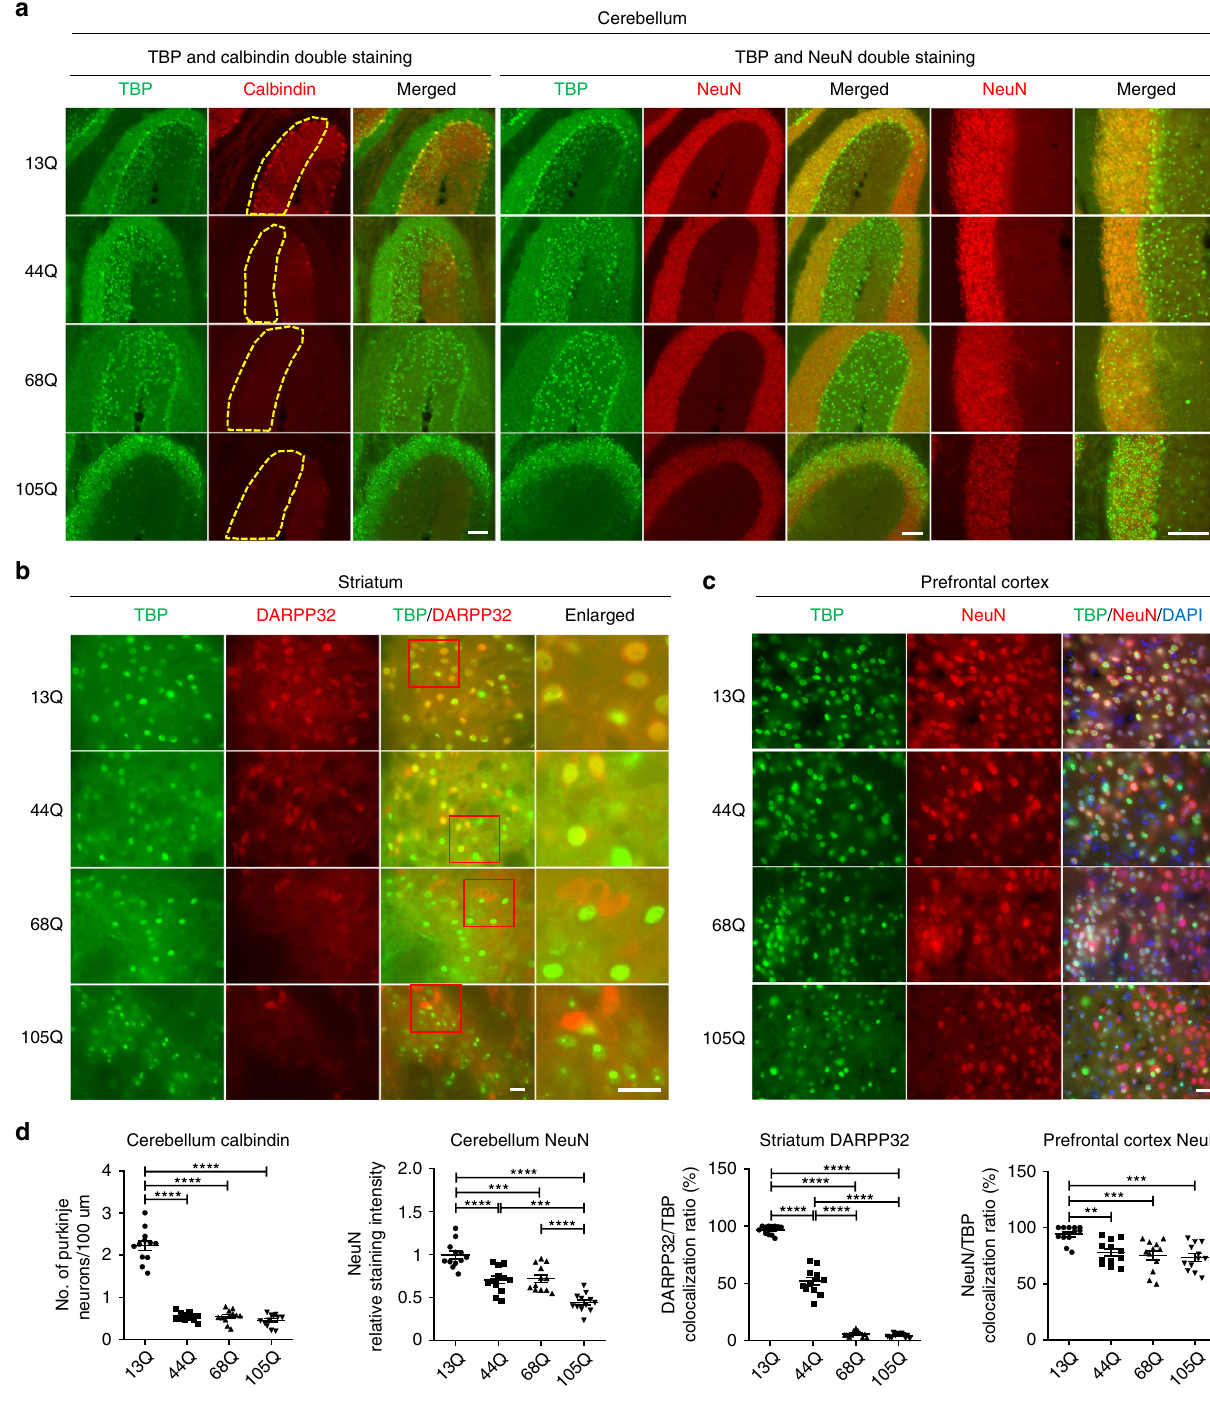
Fig. 2 Differential effects of mutant TBP in different brain regions. a Immuno fl uorescent staining of the cerebellum from AAV- TBP -injected wild-type mouse brains. Antibodies to TBP, NeuN, and calbindin were used. Scale bar = 100 μ m. b Immuno fl uorescent staining of the striatum from AAV- TBP - injected wild-type mouse brain. Staining with antibodies to TBP and DARPP32, a marker for medium spiny neurons, showed a reduced expression of DARPP32 in a polyQ length-dependent manner. Scale bar = 20 μ m. c Immuno fl uorescent staining of the prefrontal cortex from AAV- TBP -injected wild- type mouse brain with anti-TBP and anti-NeuN antibodies. Scale bar = 20 μ m. d Quanti fi cation of neuronal loss in the cerebellum, striatum, and prefrontal cortex from AAV- TBP -injected wild-type mouse brains. One-way ANOVA followed with Tukey ’ s multiple comparisons test was performed; cerebellum calbindin, F = 166.7; cerebellum NeuN, F = 31.65; striatum, F = 638.1; prefrontal cortex, F = 8.504, ** P < 0.005, *** P < 0.0005, **** P < 0.0001, n = 4 mice per group, three images per brain region from each mouse were used to count. Data are represented as mean ± SEM. Source data are provided as a Source Data fi